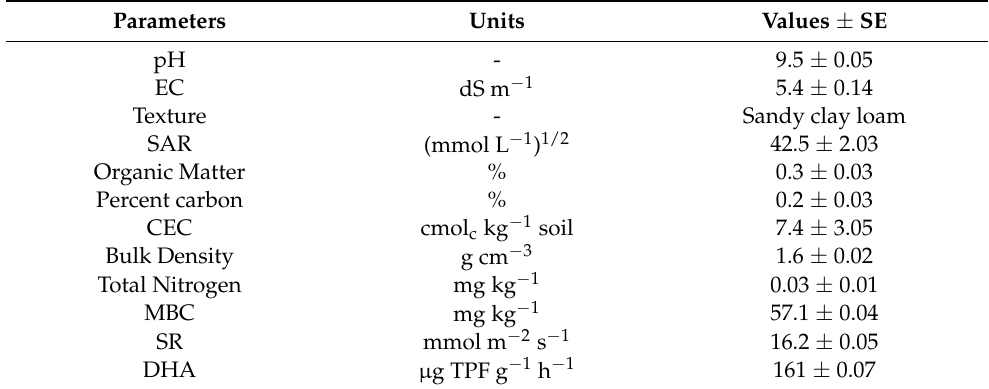
Table 1. Properties of the soil before the experiment. Rounded-off values after ± represent standard errors ( n = 3). Note: EC = electrical conductivity, SAR = sodium adsorption ra- tio, CEC = cation exchange capacity, MBC = microbial biomass carbon, SR = soil respiration, DHA = dehydrogenase